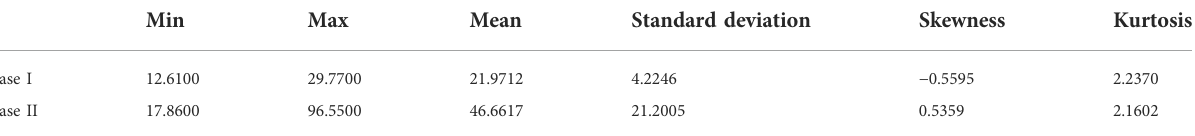
TABLE 2 The statistical analysis of the